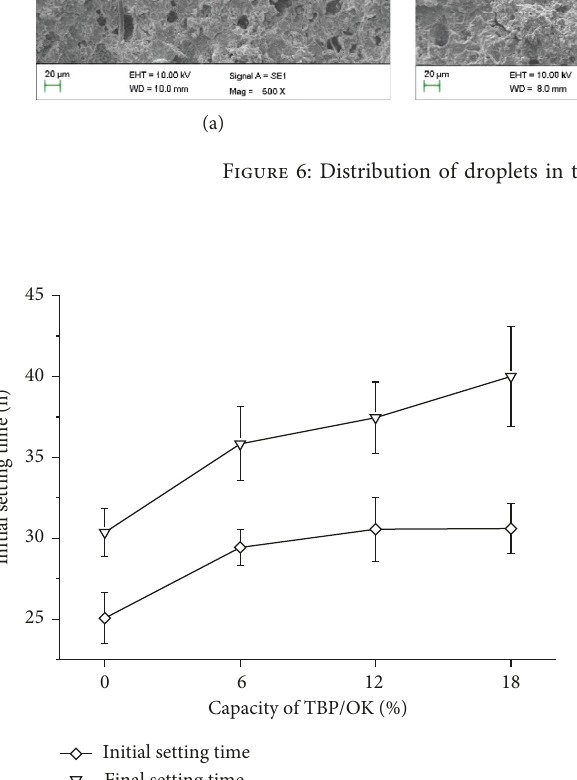
Figure 7: Setting time of the solidified SPT samples with different TBP/OK contents.